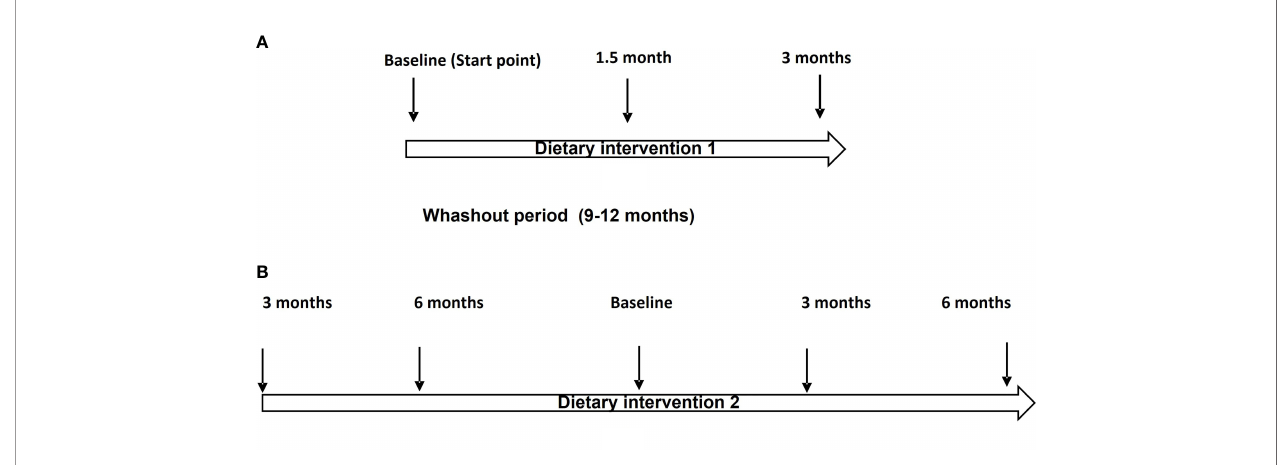
FIGURE 2 | (A) Flow chart of the Dietary Intervention protocol (DI1). (B) Flow chart of the Dietary intervention protocol (DI2).